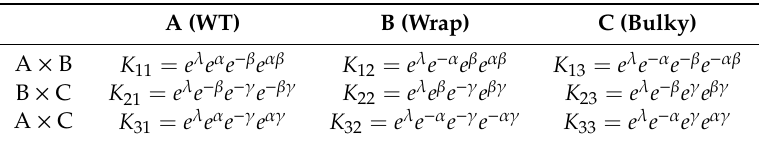
Table 4. The cell probabilities for the fully epistatic inheritance model with three genes in three crosses. The probability of phenotype j from cross i is K ij .